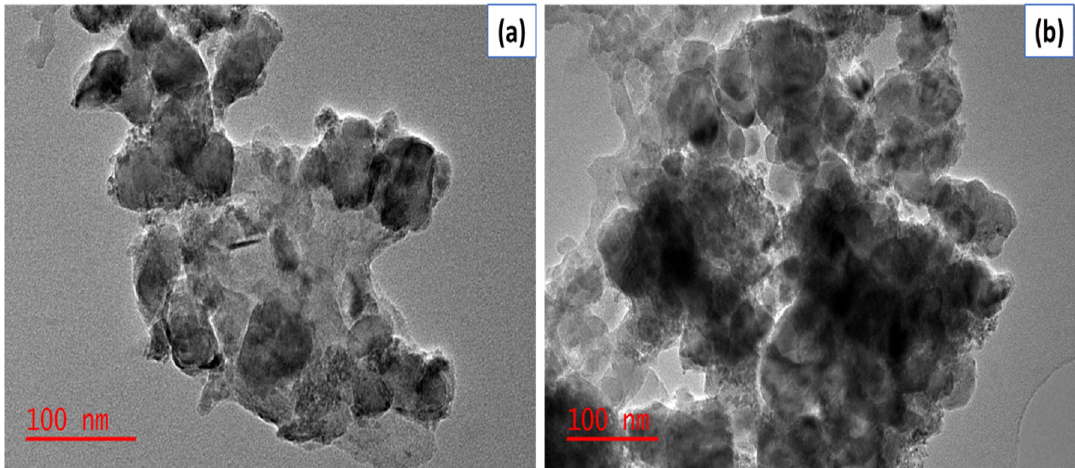
Figure 10. TEM images of Fe 3 O 4 -ZrO 2 @APS ( a ) before and ( b ) after